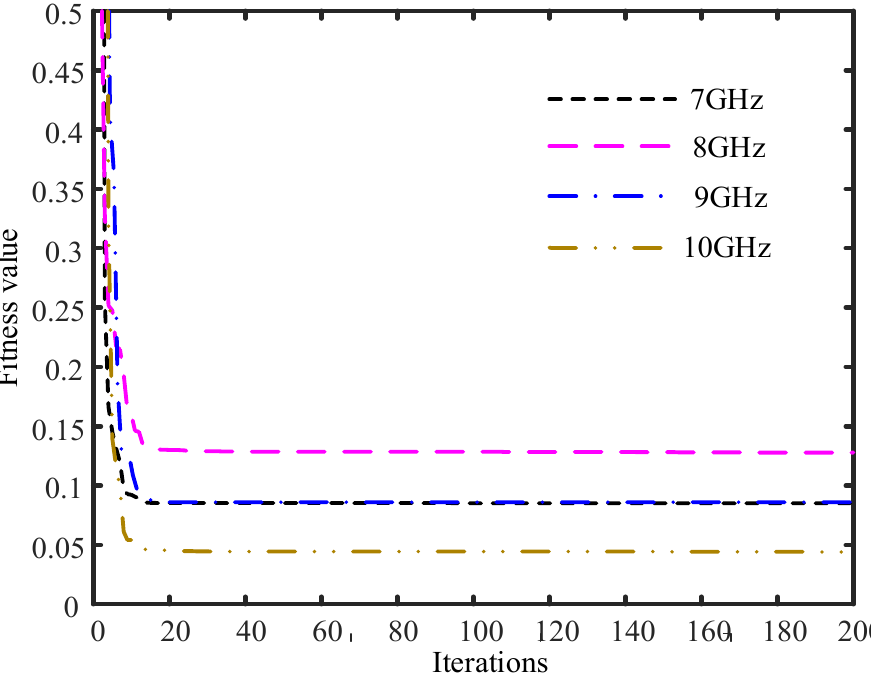
Figure 12. Convergence curves verses iterations at different frequencies for wide-nulling beampattern synthesis.